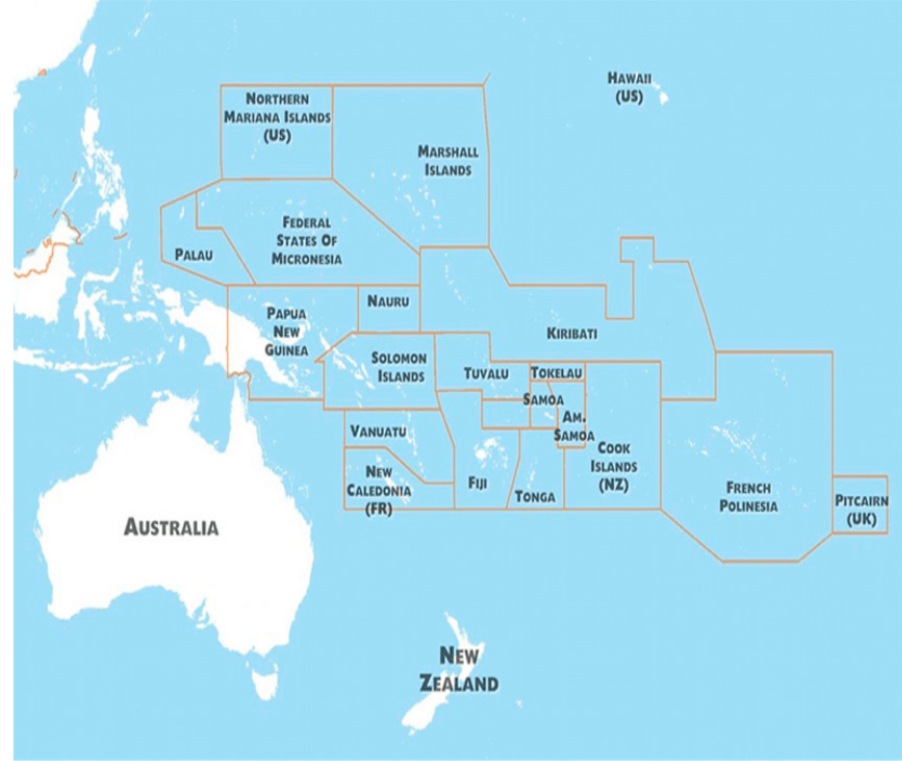
Figure 1. Countries and islands of the Pacific Region [7].